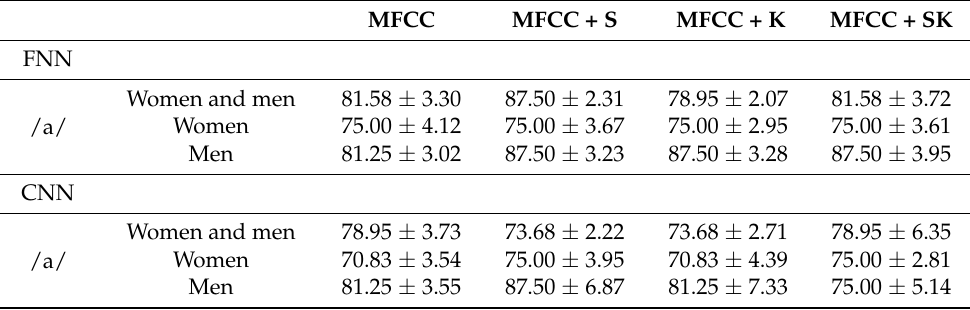
Table 4. Classification results obtained by MFCC, skewness, and kurtosis parameters and the two different deep learning methods.